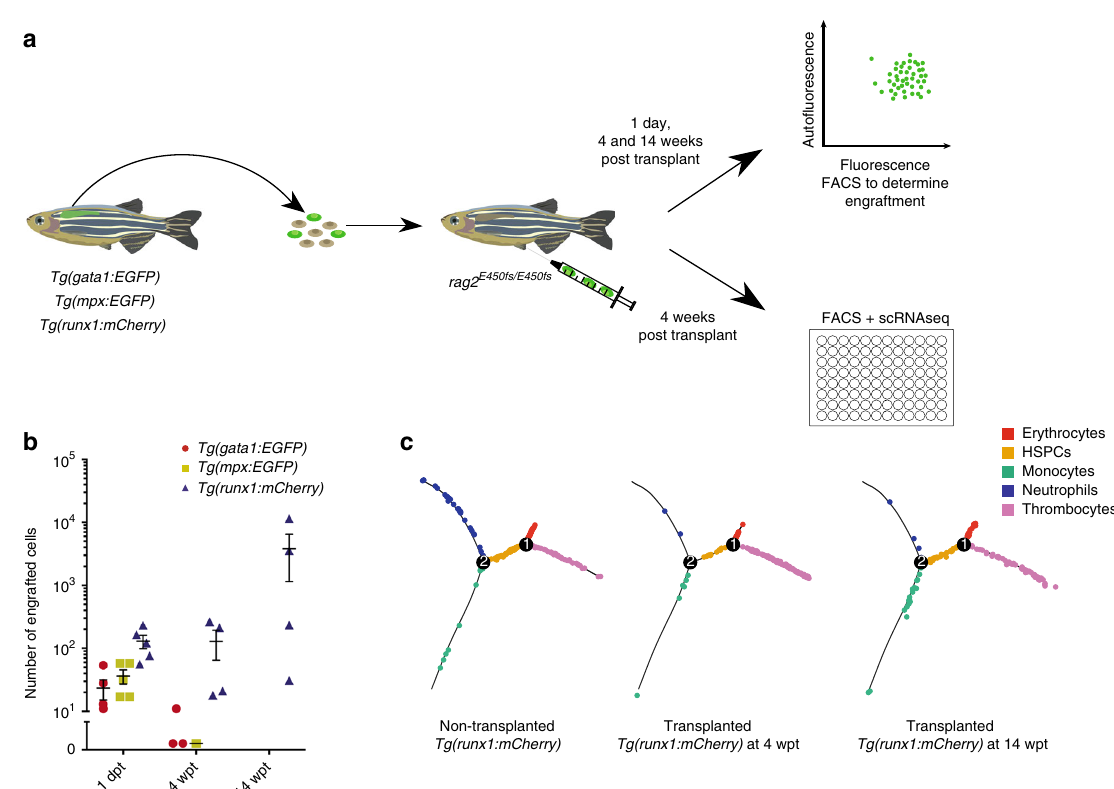
Fig. 3 Cells within distinct states have different repopulation potentials. a Experimental strategy for the adult transplantation experiment. Kidneys were dissected from transgenic donor fi sh and sorted for cells expressing the fl uorescent transgene. Positive cells were collected and injected into sublethally irradiated rag2 E450fs − / − fi sh. b Assessment for engraftment was made 1 day, 4- and 14 weeks post transplantation using fl ow cytometry. Successfully engrafted fl uorescent donor cells were isolated at 4 weeks PI by index sorting single cells into a microtitre plate for subsequent RNA-seq analyses. c Distribution of runx1 + cells, from non-transplanted (left) and transplanted fi sh at 4 (middle) and 14 wpt (right), modelled by Monocle